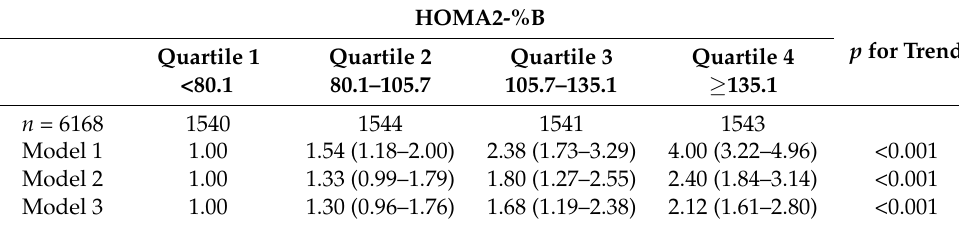
Table 2. Adjusted odds ratios (95% confidence intervals) of NAFLD according to HOMA2-B% quartiles using logistic regression.